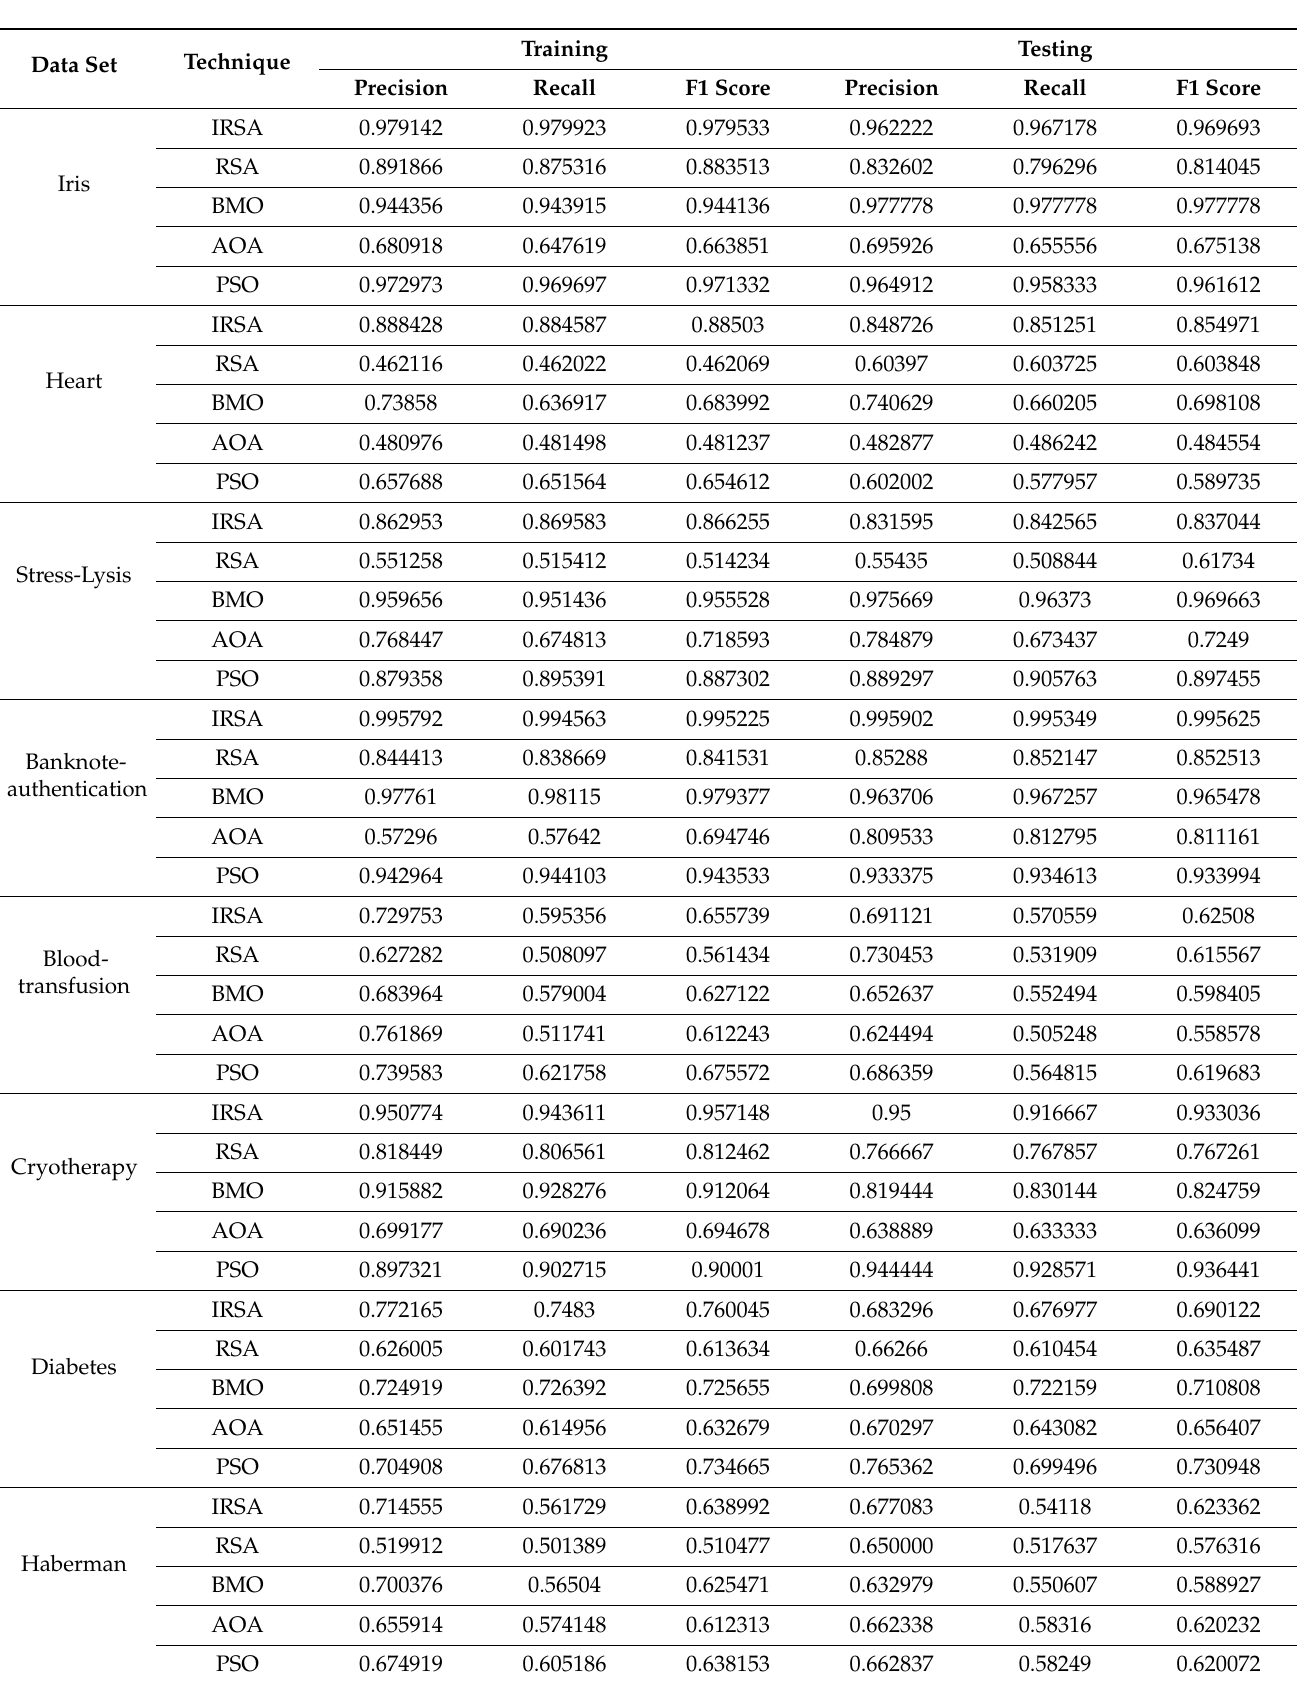
Table 10. Statistical measures for